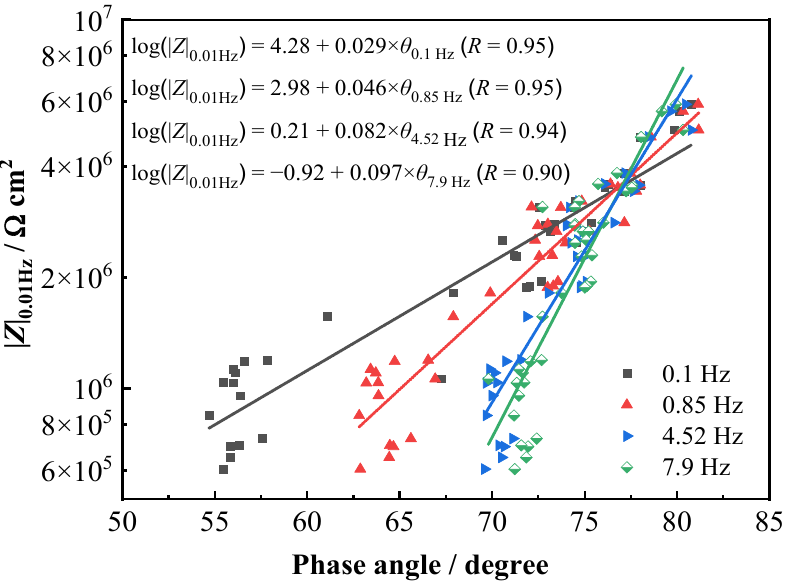
Figure 6. Fitting results of | Z | 0.01 Hz and several phase angles in middle-frequency range for T700/VE composite.